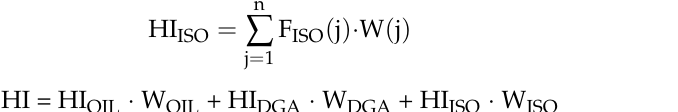
Table 2. The division of device criticality levels for the condition assessment in the presented health index.